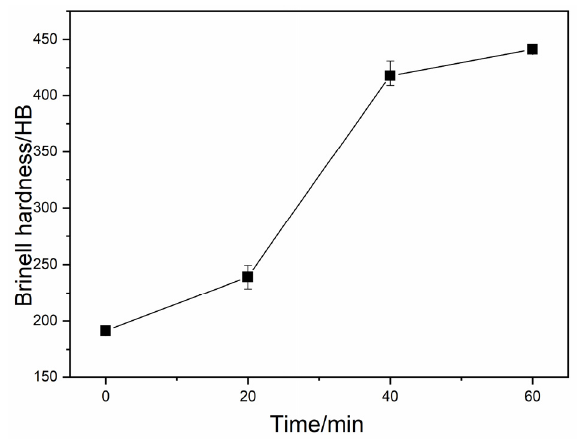
Figure 10. Brinell hardness of DI after injecting nitrogen gas for different time periods.